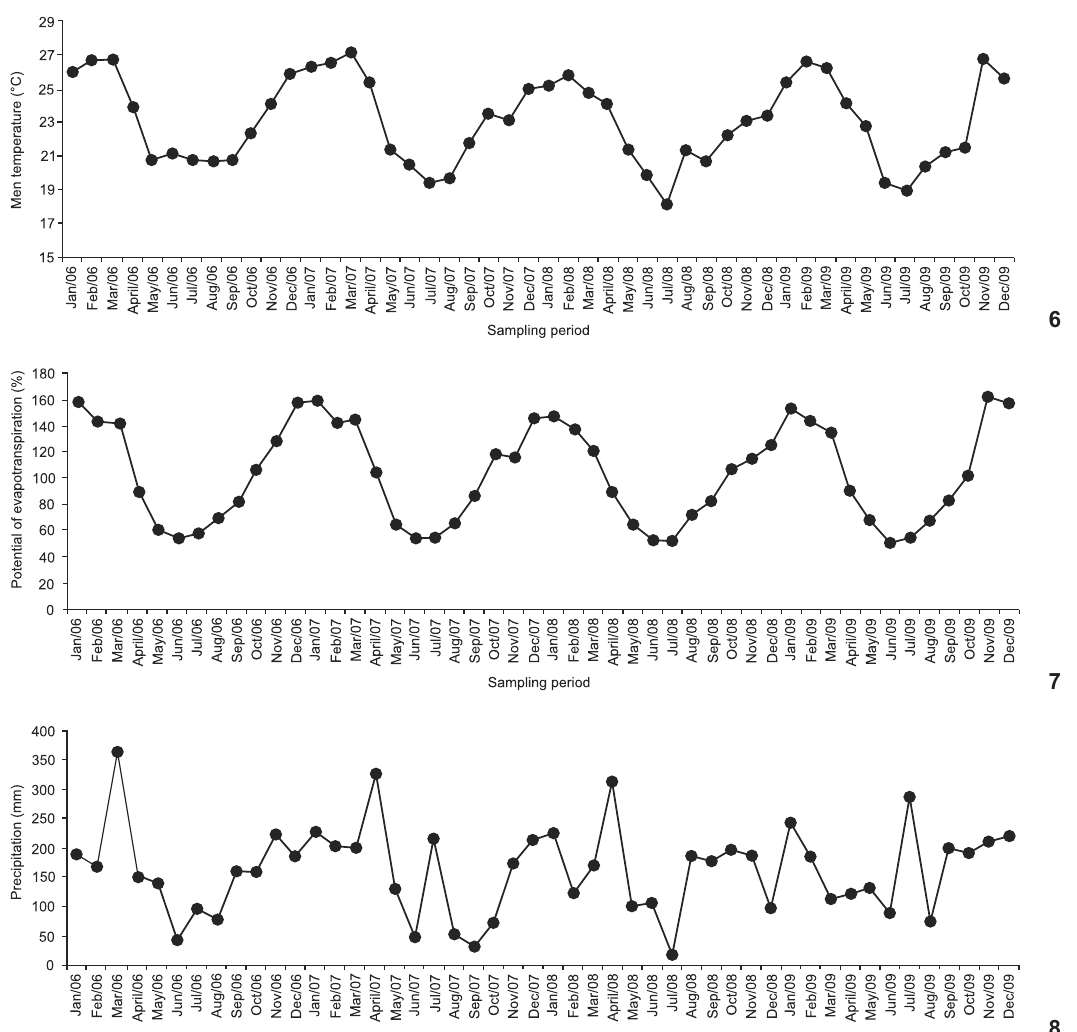
Figure 6-8. Mean values of temperature in °C (6), potential evapotranspiration in% (7) and precipitation in mm (8) during the year in the municipality of